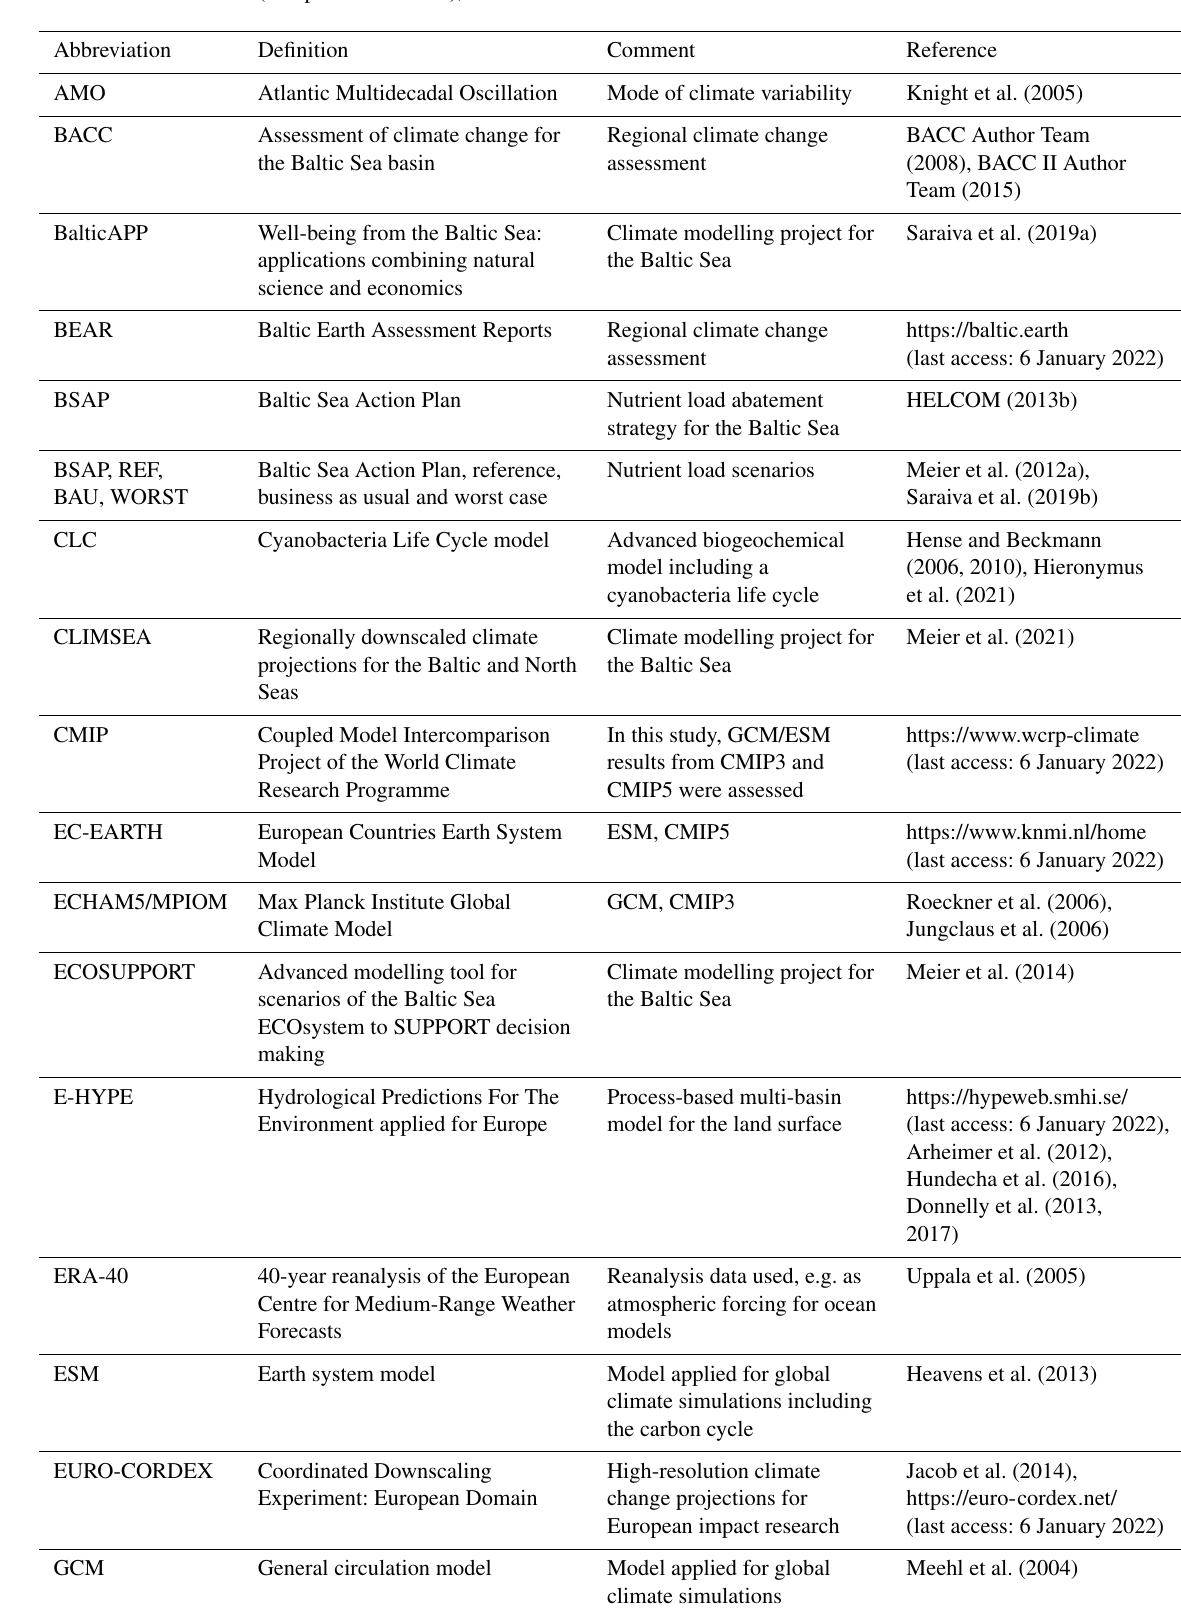
Table 5. List of abbreviations (in alphabetical order), their definitions and